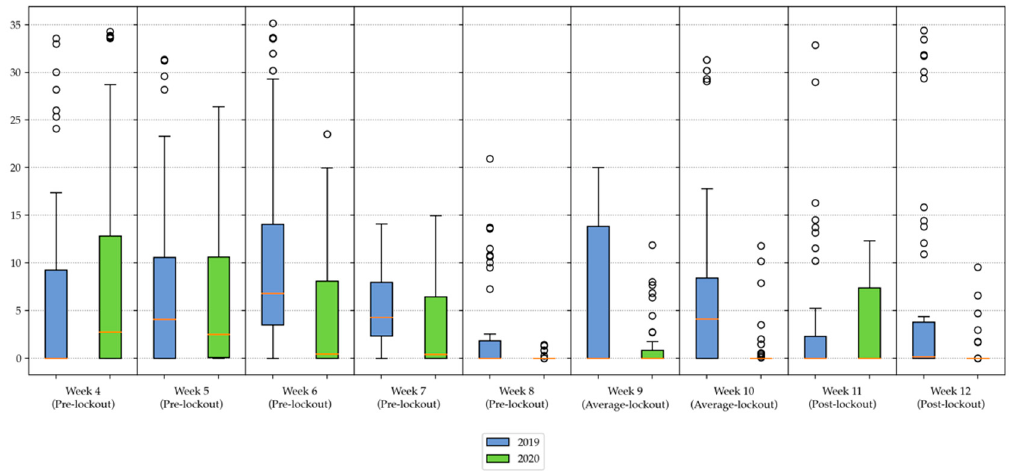
Figure 21. Weekly boxplots of the standard deviations between zonal prices in the observed weekend days’ timeframe. Energies 2020 , 13 , x FOR PEER REVIEW